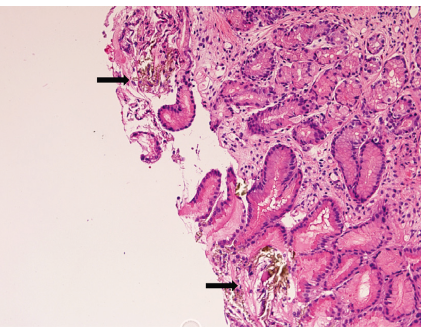
Figure 2: H&E showed focal areas of sloughed epithelium, re- fractive brown deposits (black arrows), and collections of in- flammatory cells within the disrupted gastric pits.